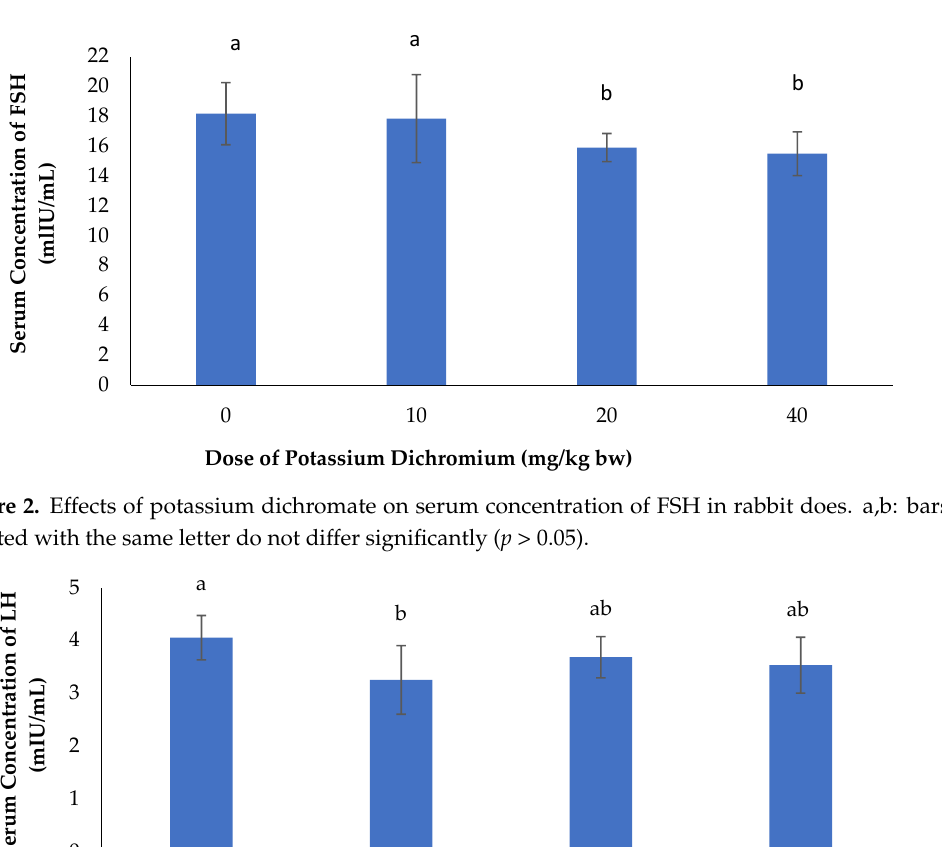
Figure 3. Effects of potassium dichromate on serum concentration of LH in rabbit does. a,b: bars affected with the same letter do not differ significantly ( p > 0.05).